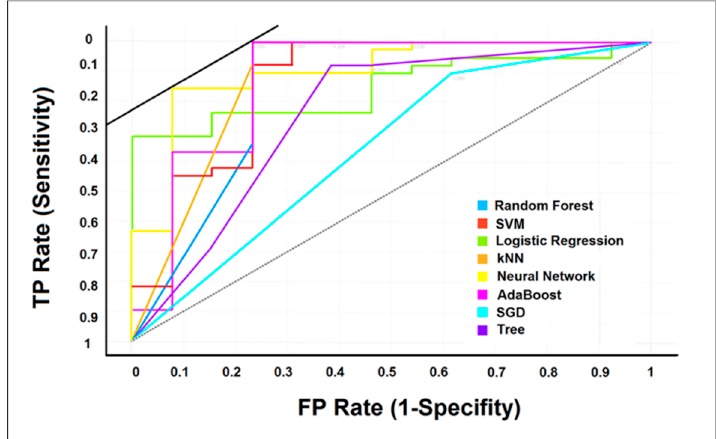
Figure 5. Receiver operating characteristic (ROC) curves for eight machine learning algorithm (MLA).